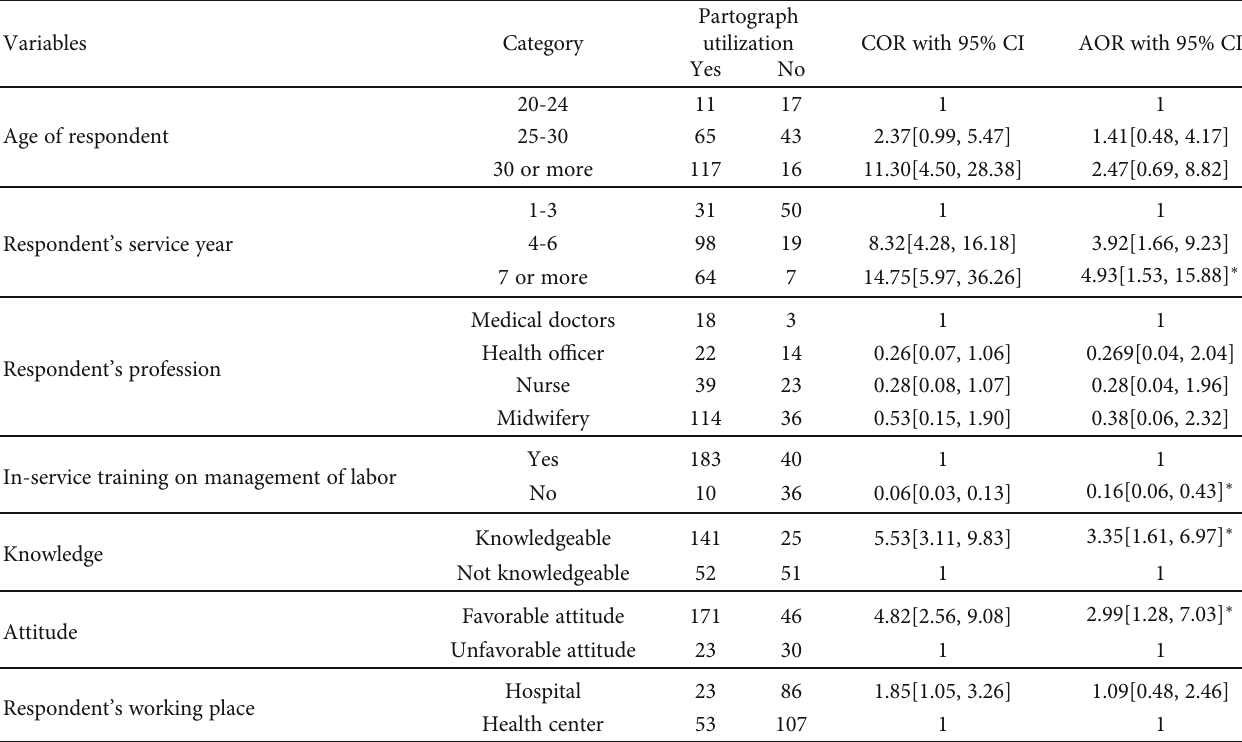
Table 4: Bivariate and multivariate analyses of factors associated with partograph utilization among obstetric caregivers in public health facilities in Wolaita Zone, SNNPR, Southern Ethiopia, Feb. 2017 ( n = 269